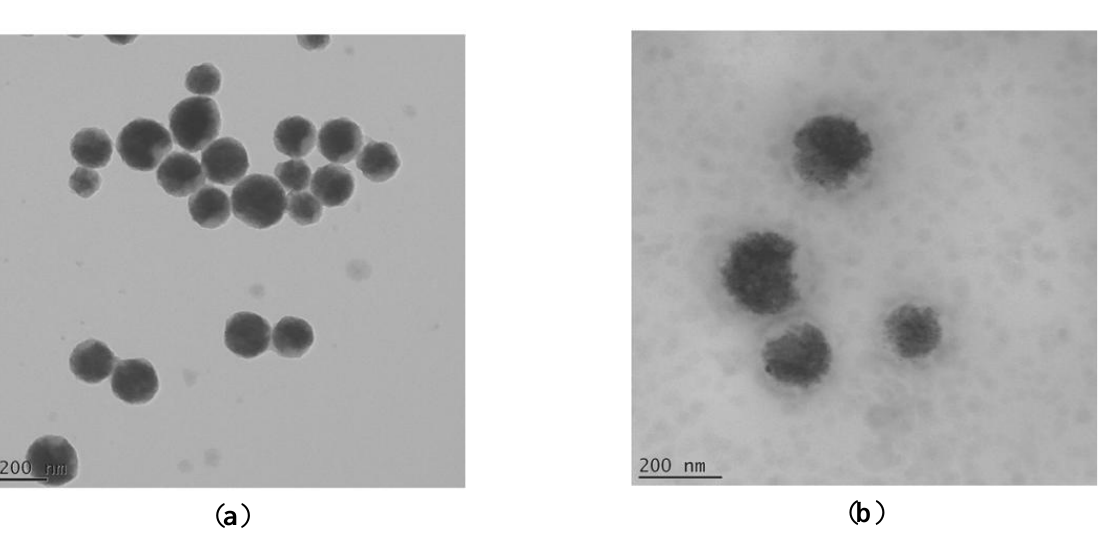
Figure 2. TEM images of magnetic nanoparticles without ( a ) and with ( b ) proteinase